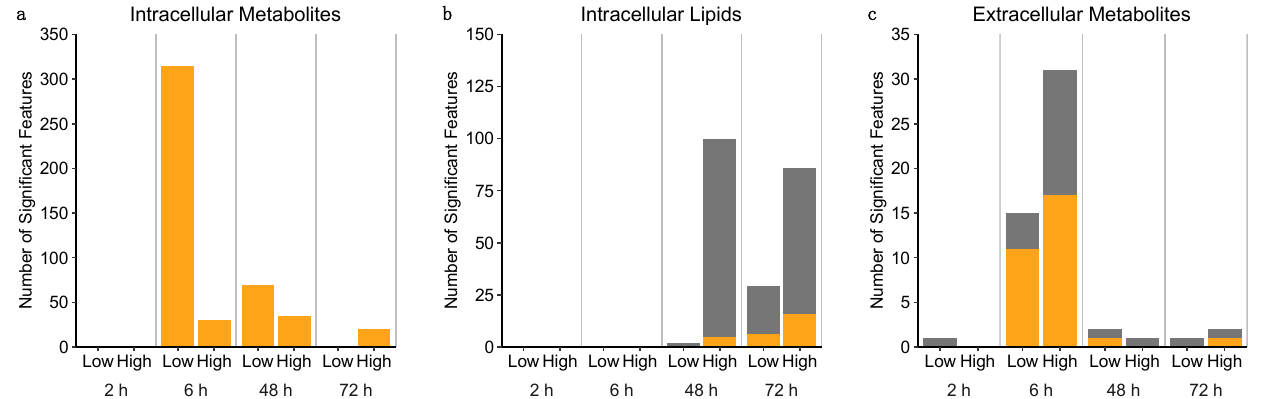
Figure 4. Bar charts summarising the number of significantly changing m/z features following the exposure of cardiac microtissues to sunitinib. Number of ( a ) intracellular metabolite, ( b ) intracellular lipid and ( c ) extracellular metabolite features whose intensities changed significantly upon exposure to two concentrations of sunitinib for 2, 6, 48 or 72 h, relative to controls. Stacked bars show contribution of measurements from positive (grey) and negative (yellow) ionisation-based assays. Significance defined where q < 0.1, one-way ANOVA with Tukey’s HSD post hoc test and false discovery rate correction.